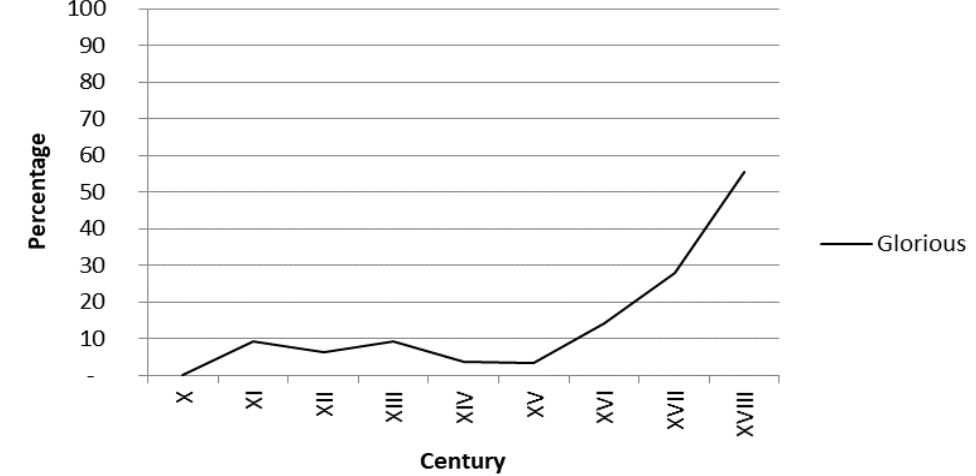
Figure 5. Presentations of Mary as glorious in heaven (Spain, tenth to eighteenth centuries). Source: Authors’ elaboration based on Trens (1946).